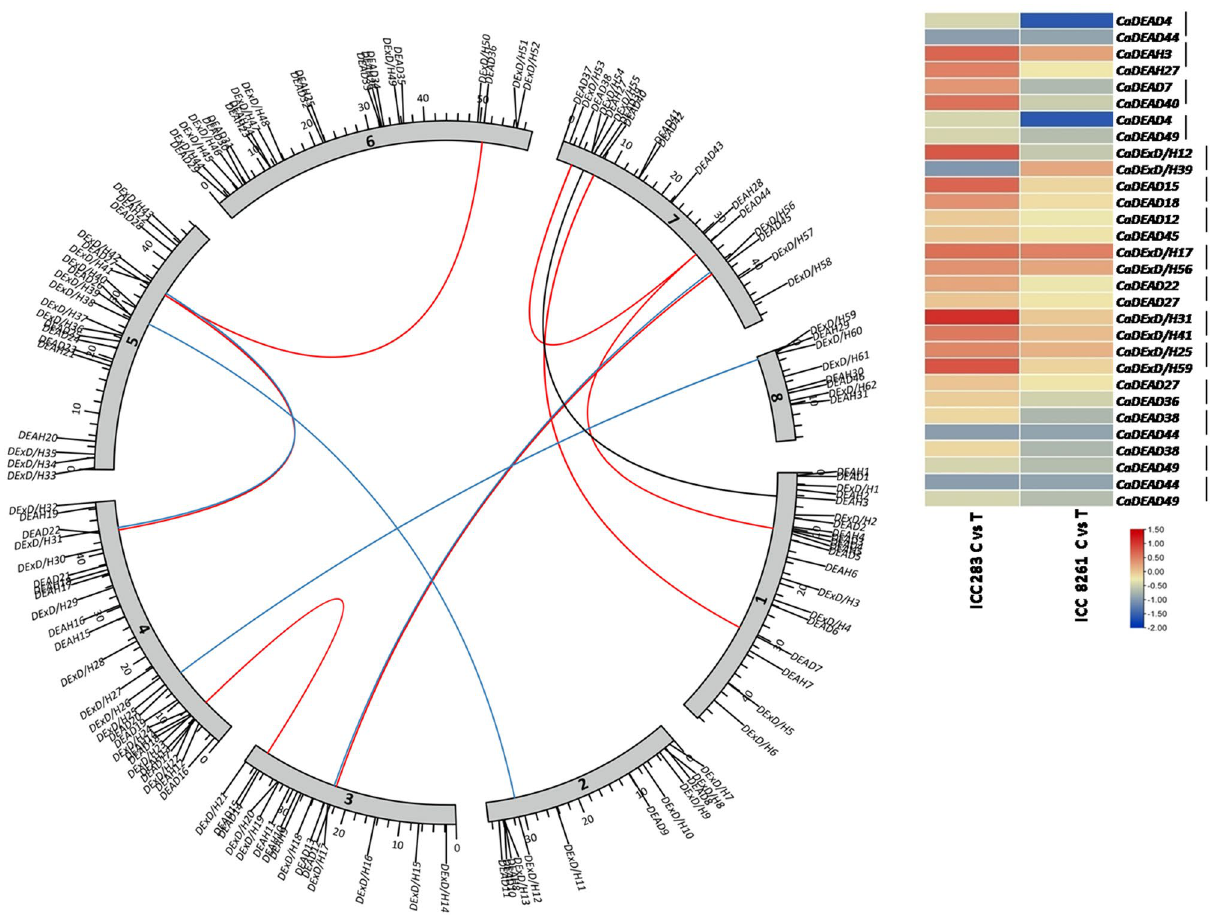
Figure 3. The distribution of duplicated RNA helicase gene pairs across the chickpea chromosomes. The red, black and blue lines in the Circos plot connect the duplicate CaDEAD , CaDEAH and CaDExD/H -box genes, respectively. These are 12 in number as the gene pairs (3) located on scaffolds are not represented. A total of 15 duplicate gene pairs were identified, whose expression levels in terms of log2 FC on exposure to drought stress treatment, derived from publicly available RNA-Seq data of leaf tissues from two contrasting genotypes, ICC 8261, drought tolerant and ICC 283, drought sensitive, are shown as heatmap. Vertical lines connect the genes constituting the duplicated gene